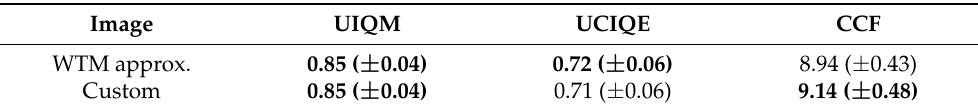
Table 6. Mean image quality metrics for custom tone-mapped images and their successful WTM < 5). approximations (mean ∆ E ∗ ab